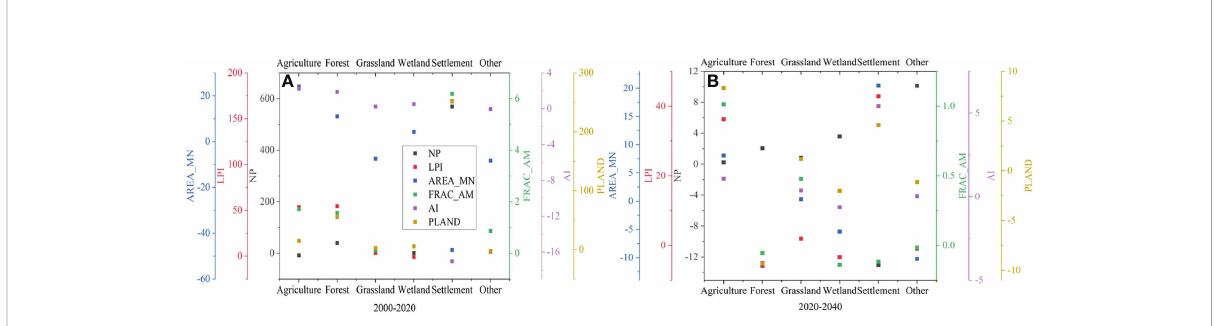
FIGURE 4 Percentage of landscape metrics changes of each LULC class for 2000-2020 (A) and 2020-2040 (B) . NP number of patches; LPI, largest patch index; AREA_MN, mean patch area; FRAC_AM, area weighted mean fractal dimension index; AI, aggregation index; PLAND, percentage of